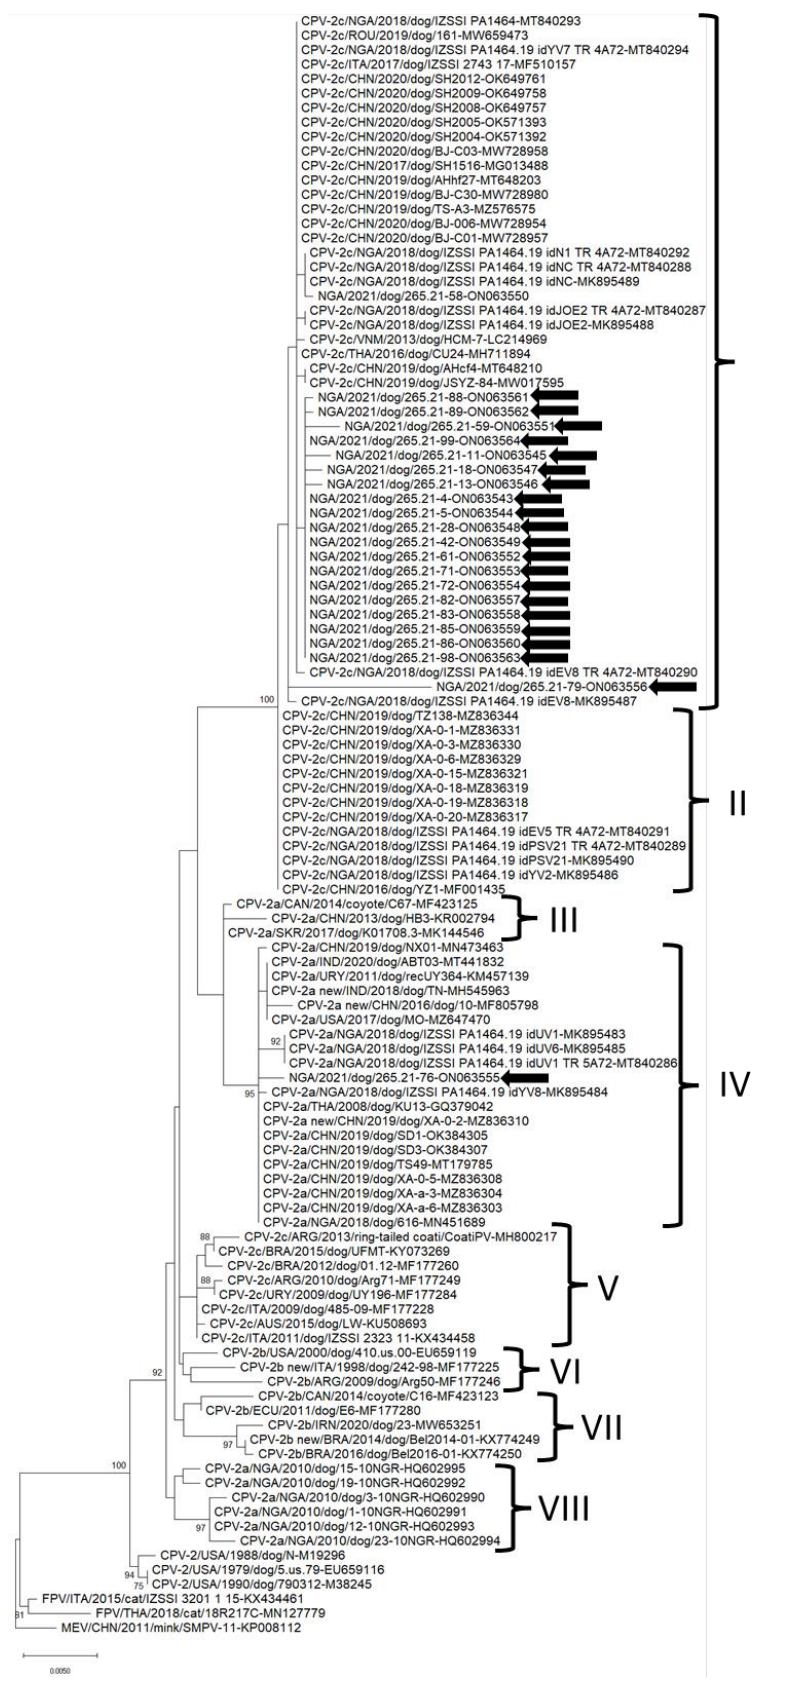
Figure 2. Phylogenetic tree based on the complete ORF2 sequence (1755 nt) of